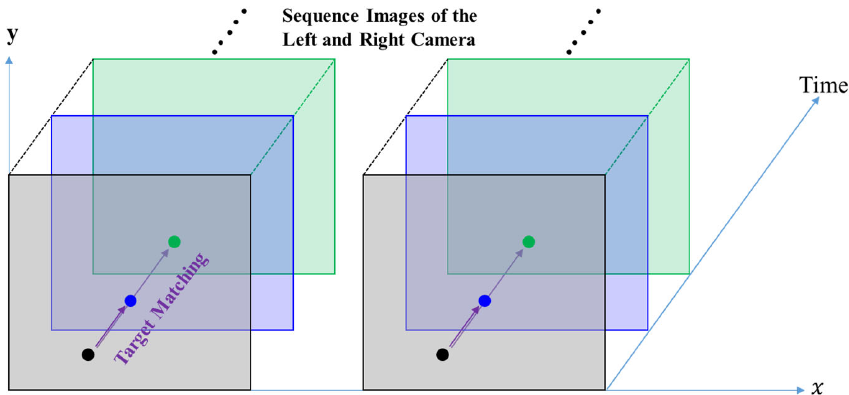
Figure 3. Matching to obtain image coordinates of the targets in sequence